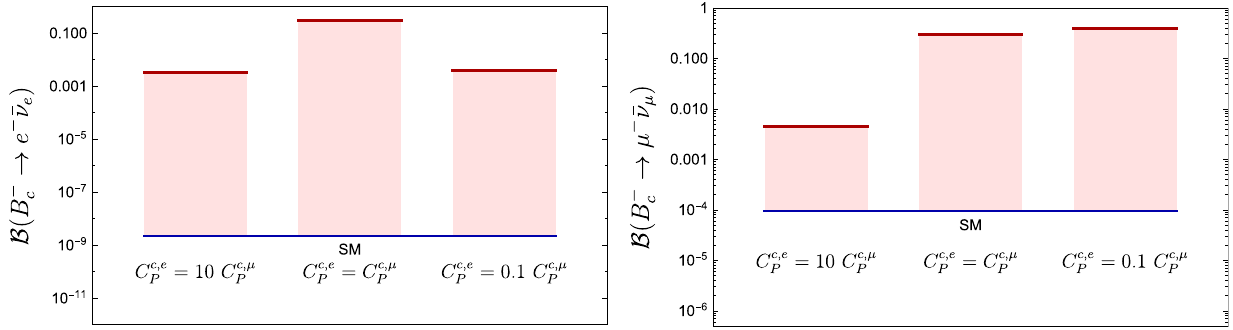
,μ and C c for (cid:2) (cid:6) = e ,μ P P